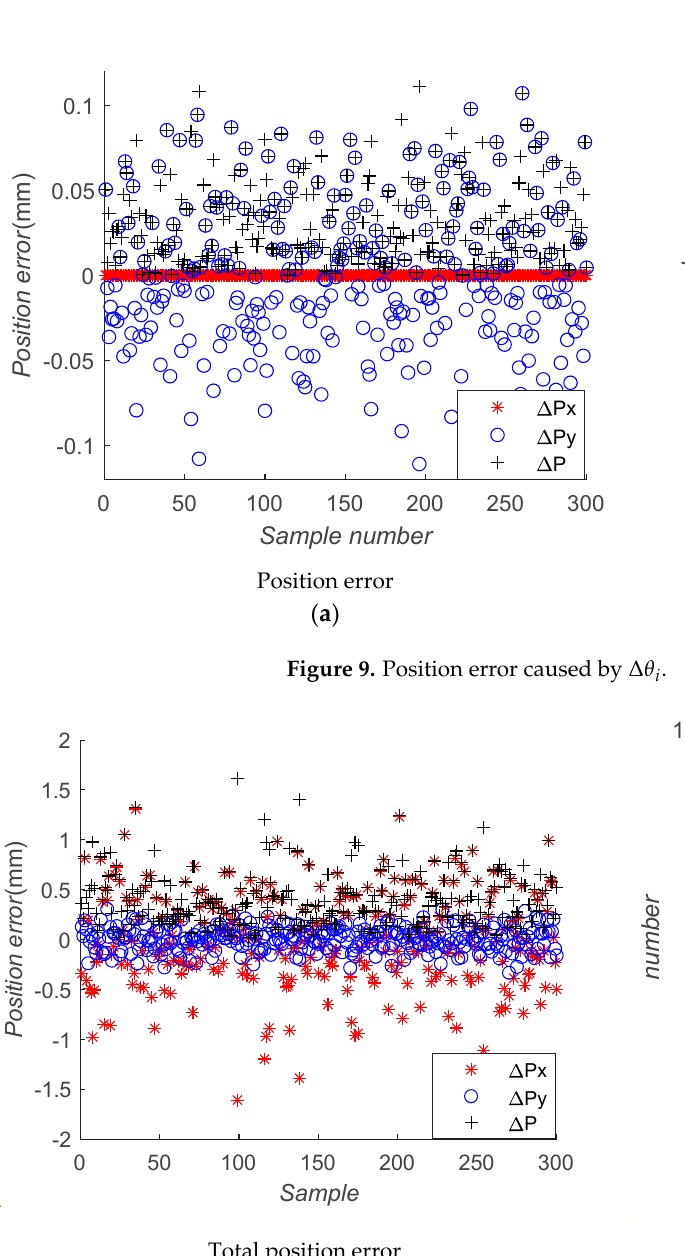
Figure 10. Total position error.